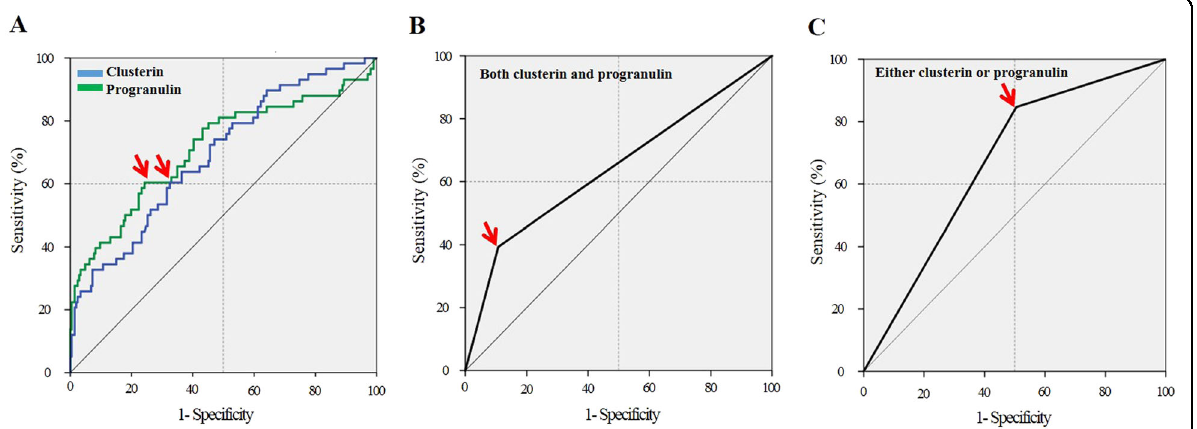
Fig. 2 Receiver operating characteristic curve for the best cutoff value of serum clusterin/progranulin ( a ), as well as combined values ( b , c ) to identify TDI-OA subjects. Arrows indicate the optimal cutoff value